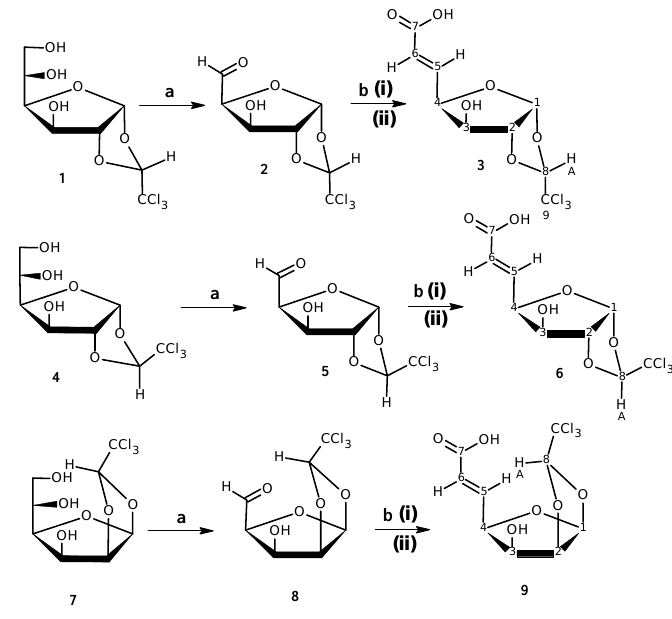
values (Hz) of H,H